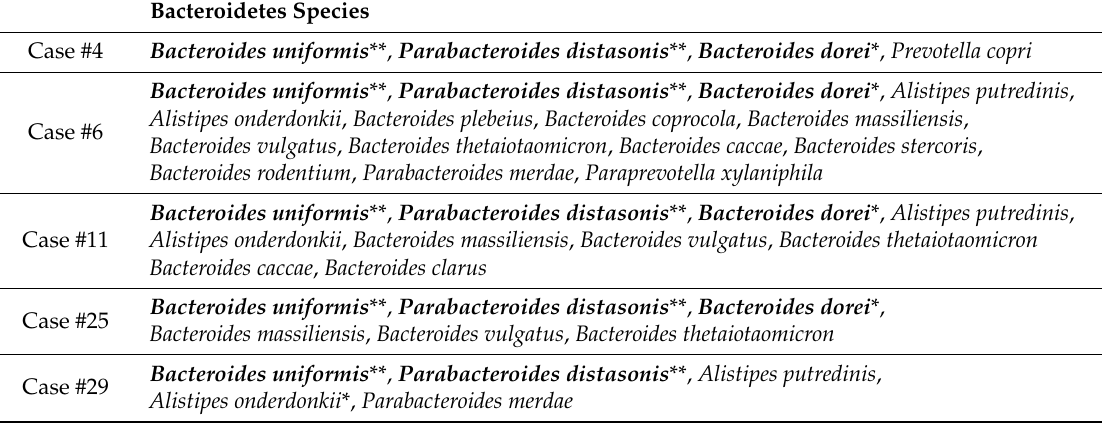
Table 3. Types of Bacteroidetes species that existed in donors and continued to exist in five patients who maintained without recurrence for 24 months.